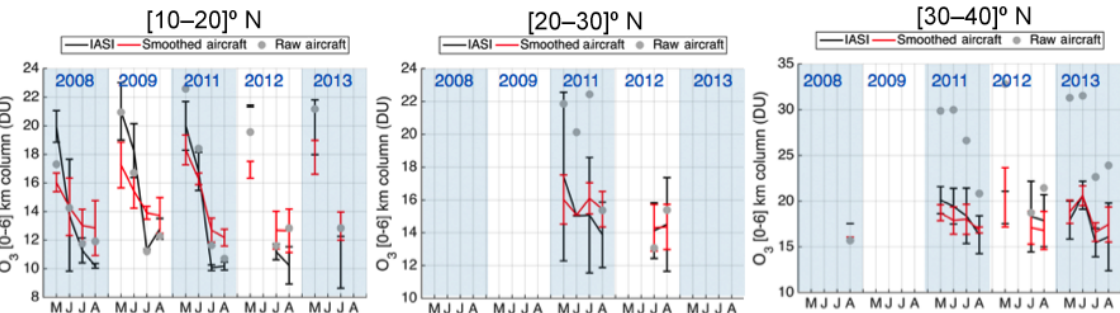
Figure 5. Time series of 0–6km available O 3 columns from co-located IASI (black) and aircraft (smoothed in red and raw in grey) data at the airports (Fig. 3) averaged between 10–20, 20–30 and 30–40 ◦ N from May till August of 2008 to 2013. No aircraft data were recorded in